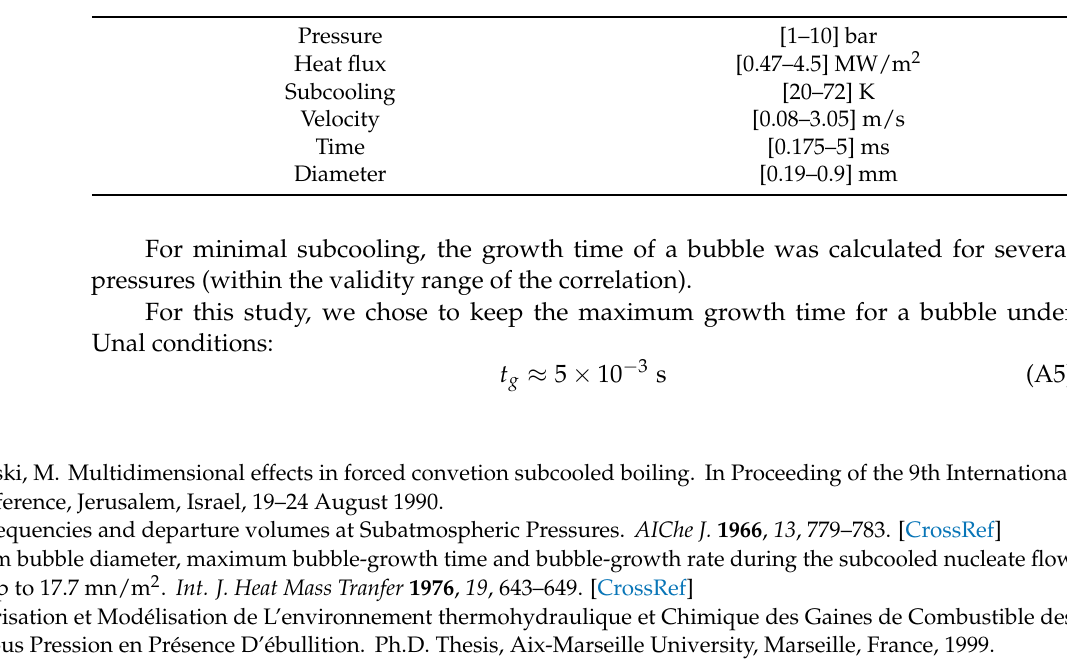
Table A1. Range of validity of Unal correlation